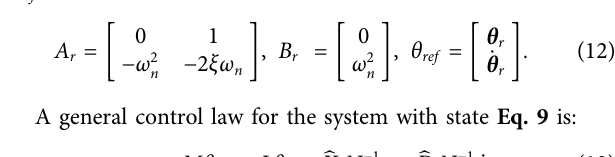
TABLE 4 | Reference model and MRAC parameters. Parameter